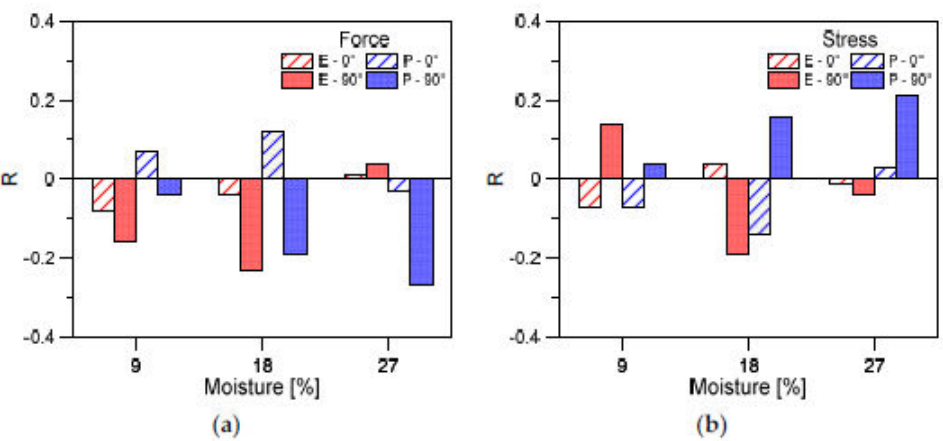
Figure 15. Average experimental failure load versus the ratio of analytical prediction, as obtained for specimens with ( a ) epoxy or ( b ) polyurethane adhesive and parallel rod-to-grain